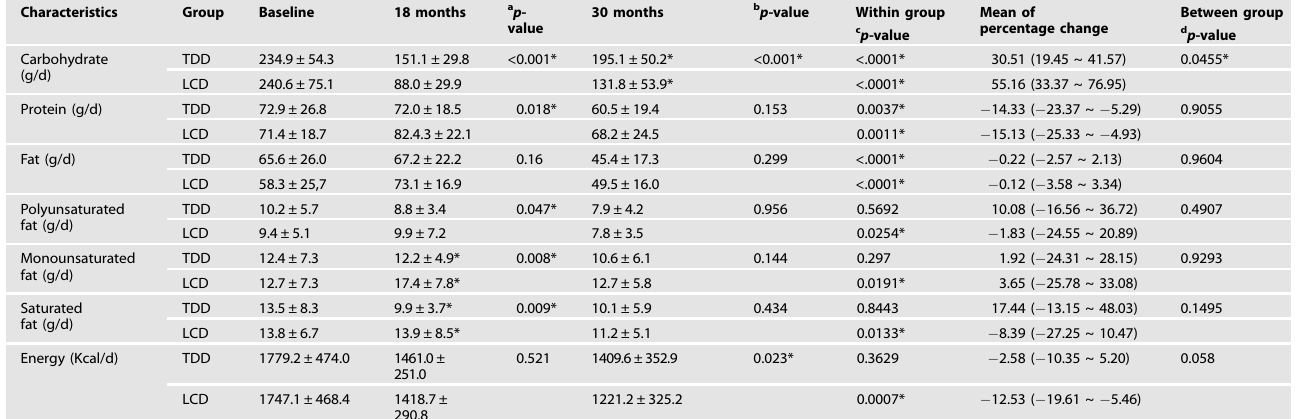
Table 2. Data of baseline, 18 months, and 30 months for patients in the traditional diet and the low-carbohydrate diet.